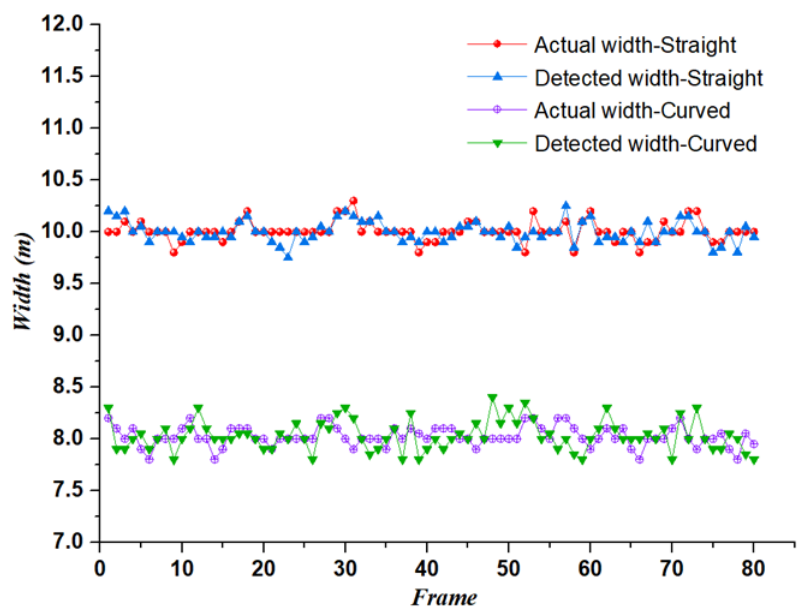
Figure 10. Comparison of detected road width and actual road width.